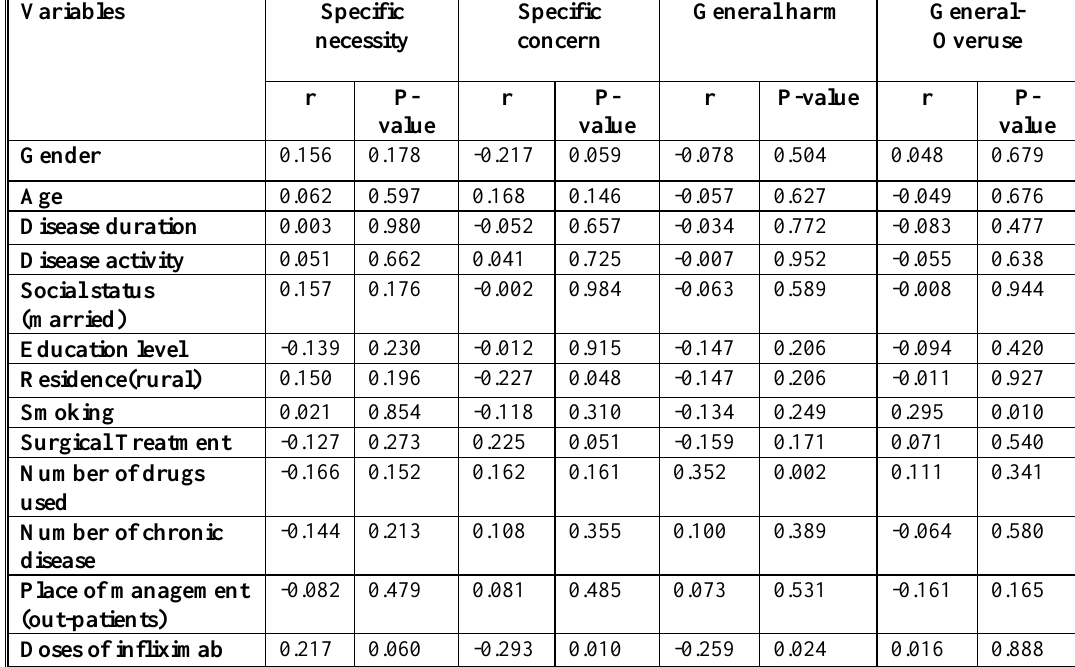
Table 8. Linear regression analysis between BMQ components and other variables for CD patients